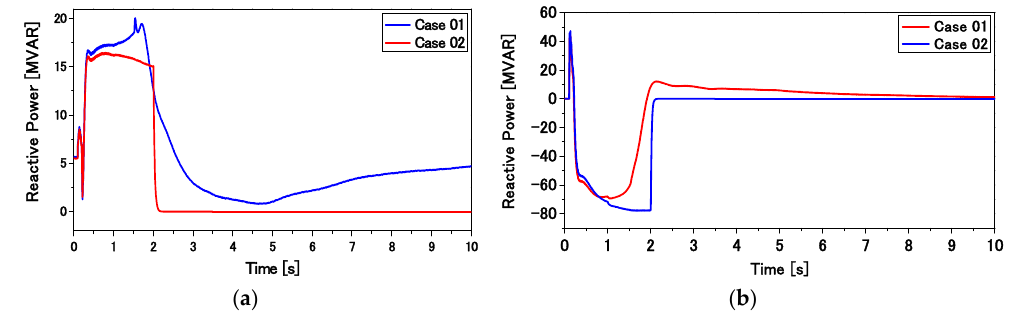
Figure 24. Reactive power output of wind generators: ( a ) DFIG; ( b )